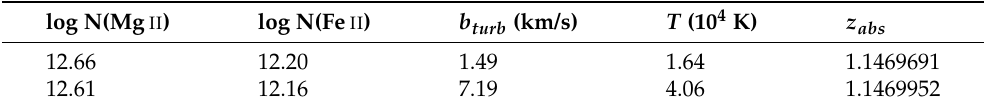
Table 2. Absorption line parameters used to generate the spectrum illustrated in Figure 3. See Section